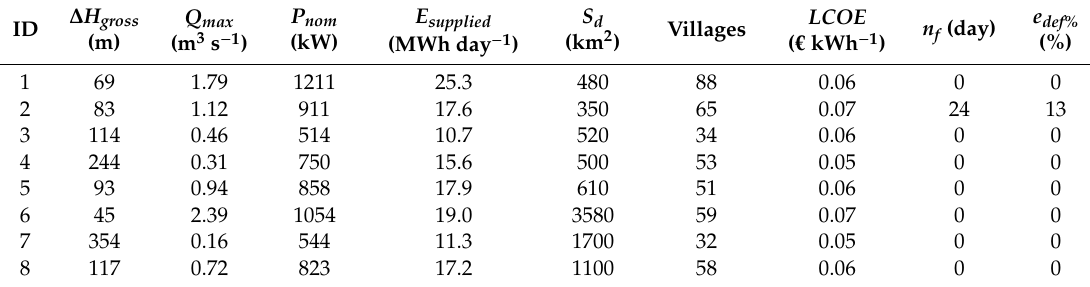
Table 6. Poli-ROR . Optimal solution. Characteristics of the best mini-grid (see Figure 6)